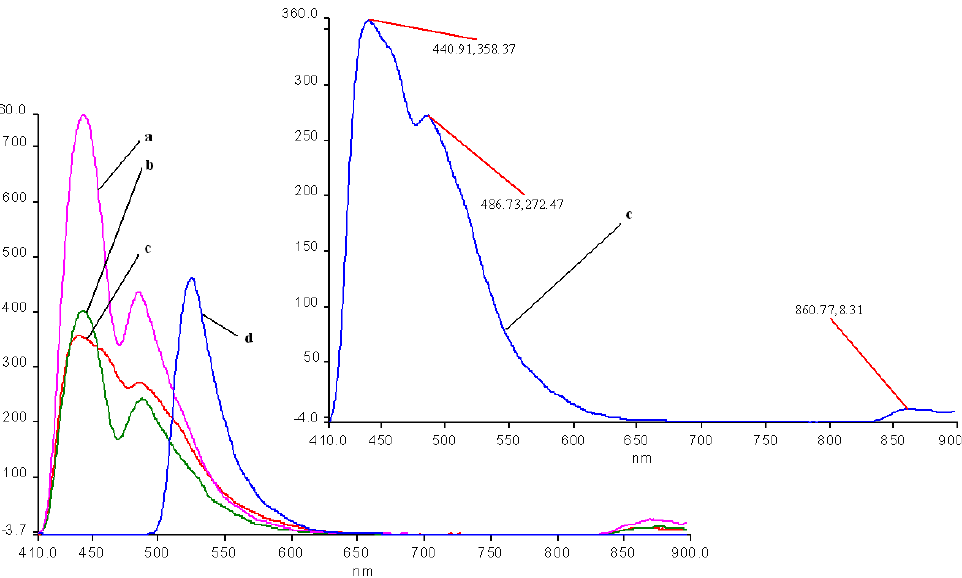
Figure 8. The influence of pH on the emission spectra of 2b in a THF/water system ( λ 250 nm-filter 430 nm). Curve a: pH = 1; curve b: pH = 1.5; curve c: 2b in THF; curve d: pH = 11; in detail: curve